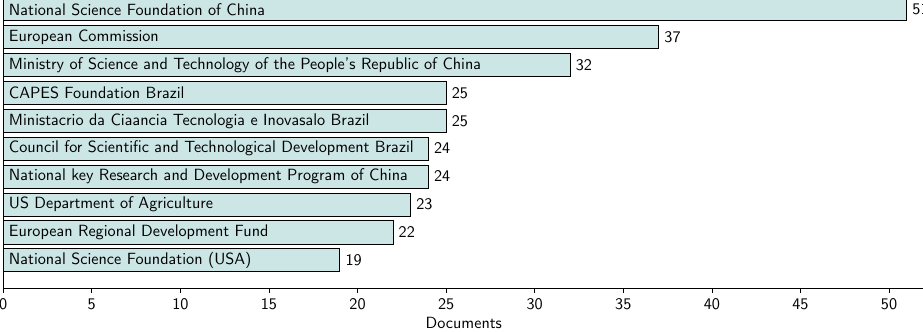
Figure 12. Popular funding sponsors with the most publications on adopting